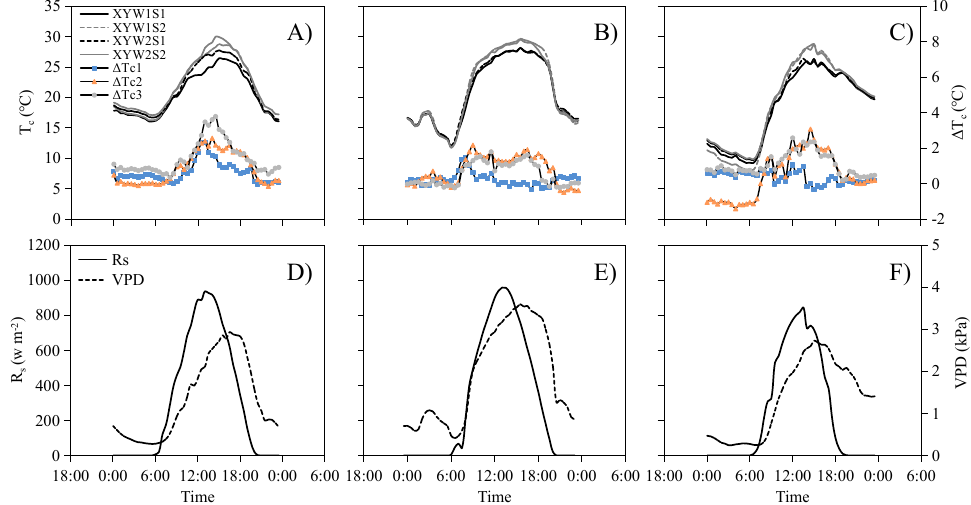
Figure 2. Canopy temperature (T c ) and differences in T c between treatments ( ∆ T c ), ( A – C ) for XY335 maize genotype and corresponding diurnal courses of solar radiation (R s ) and vapor pressure deficit (VPD), ( D – F ). W1 and W2 are full and regulated deficit irrigation, and S1 and S2 salt-free and 2‰ soil salt content treatments, respectively. ∆ T c1 , ∆ T c2 , and ∆ T c3 represent the temperature differences between W2S1, W1S2, and W2S2 with W1S1, respectively. The data are three typical days of the late vegetative stage (V stage, 7/1), ( A , D ), reproductive stage (R stage, 7/26), ( B , E ), and maturation stage (M stage, 8/28), ( C , F ), respectively.